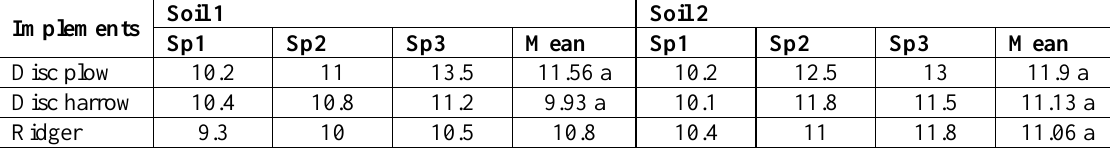
Table 5. Effect of different forward speeds and two different soils on wheel slippage as a percentage (%) Implements Disc plow Disc harrow Ridger Means with the same letters are not significantly different.